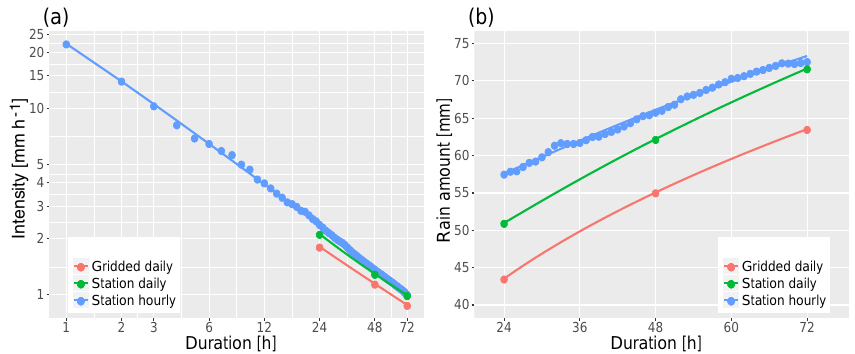
Figure 1. Dependence of (a) intensity in mmh − 1 and (b) accumulated rain amount (depth) in mm on rainfall duration. Blue: Berlin station data with hourly resolution; green: Berlin station data with daily resolution; red: closest grid point to Berlin from E-OBS data set at daily resolution. Dots indicate result of POT analysis, and solid lines are the fitted IDF and DDF curves (see text for